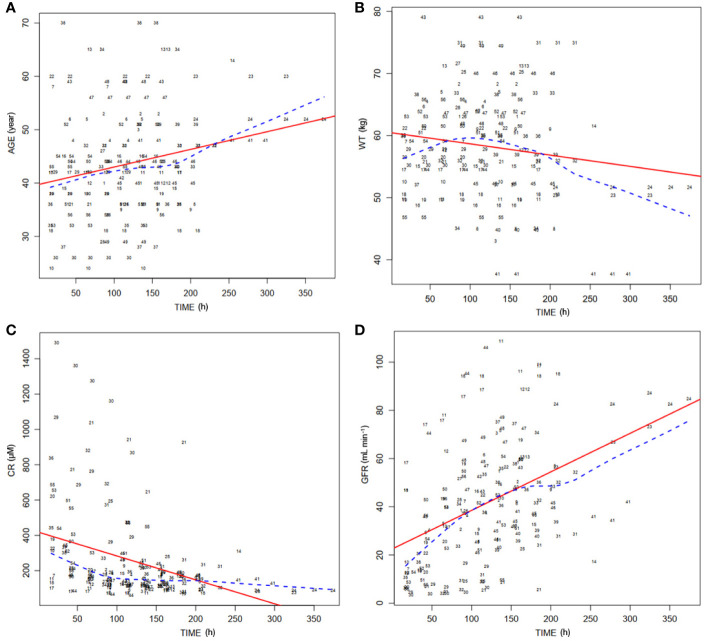
Distribution of covariates of 56 patients over time posttransplantation. (A) Distribution of ages of patients (AGE) in the postoperation duration. Dashed line, medians of the ages; solid line, fitting curve of ages over time. (B) Distribution of body weights of patients (WT) during posttransplantation period. Dashed line, medians of WT; solid line, fitting curve of WT over time. (C) Distribution of serum concentrations of creatinine (CR) in the postoperation duration. Dashed line, medians of CR; solid line, fitting curve of CR over time. (D) Distribution of theoretical glomerular filtration rates (GFR) during posttransplantation period. Dashed line, medians of GFR; solid line, fitting curve of GFR over time.